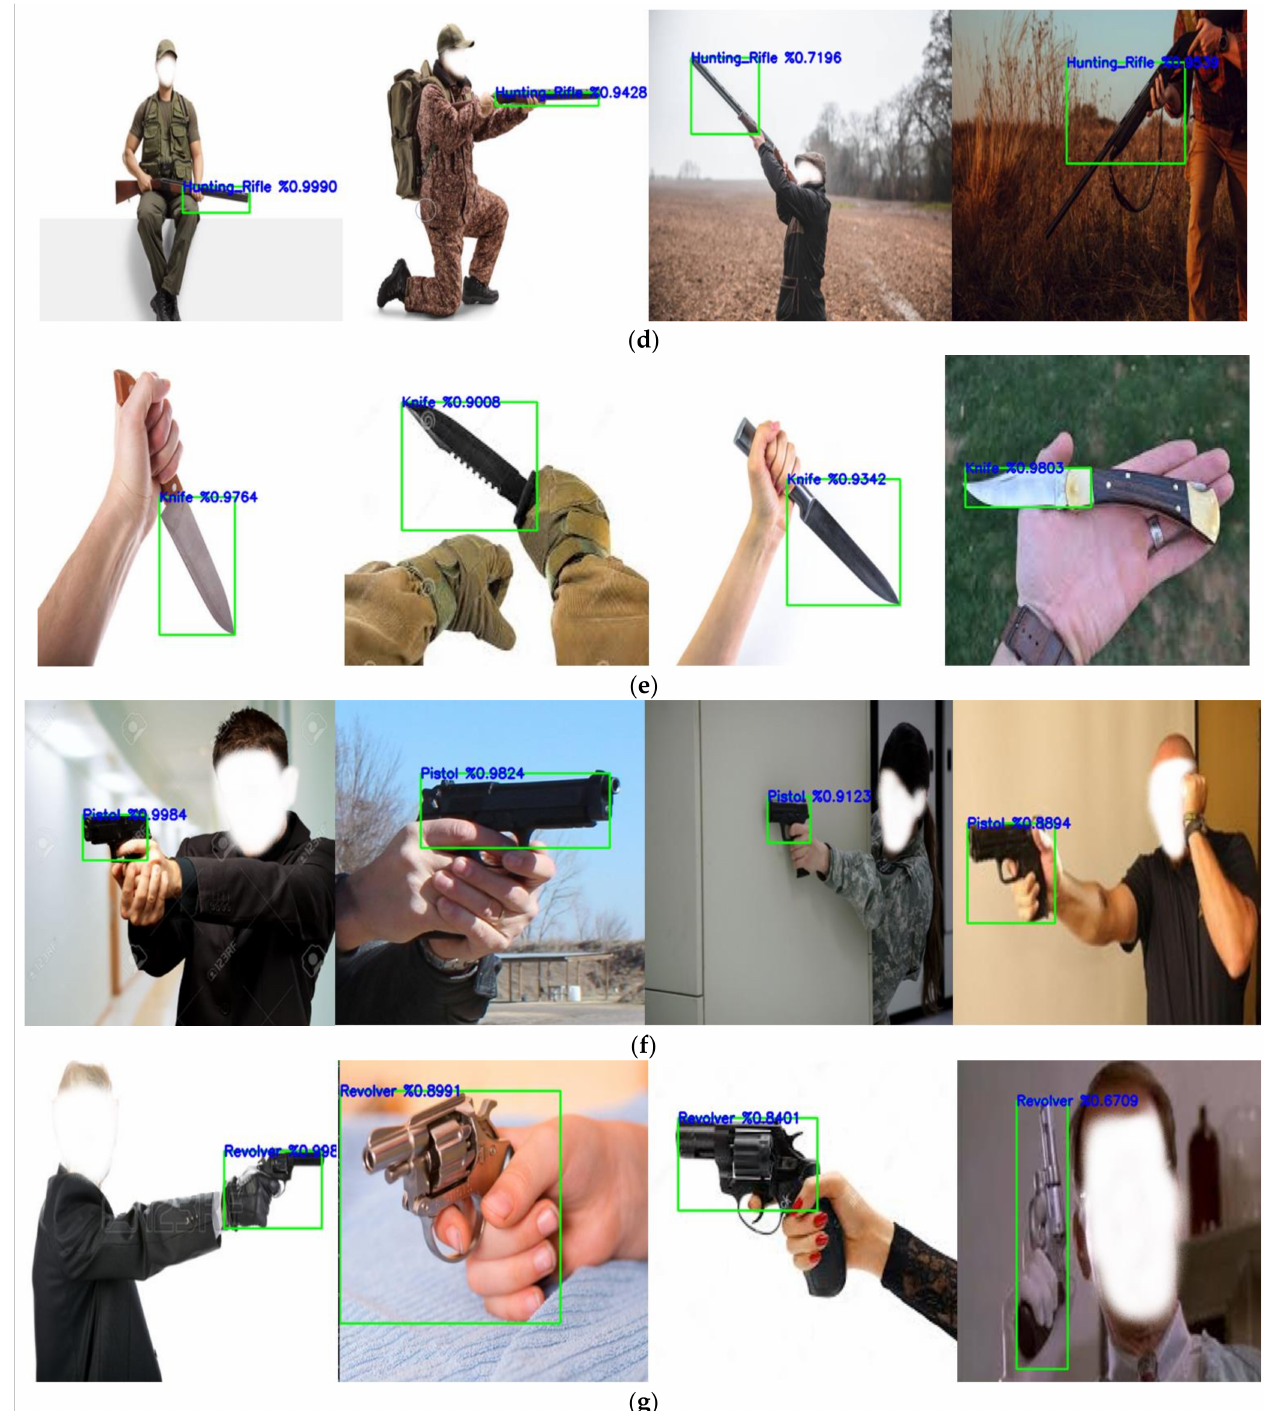
Figure 7. Sample test results for different classes: ( a ) assault rifles; ( b ) bazookas; ( c ) grenades; ( d ) hunting rifles; ( e ) knives; ( f ) pistols; ( g )